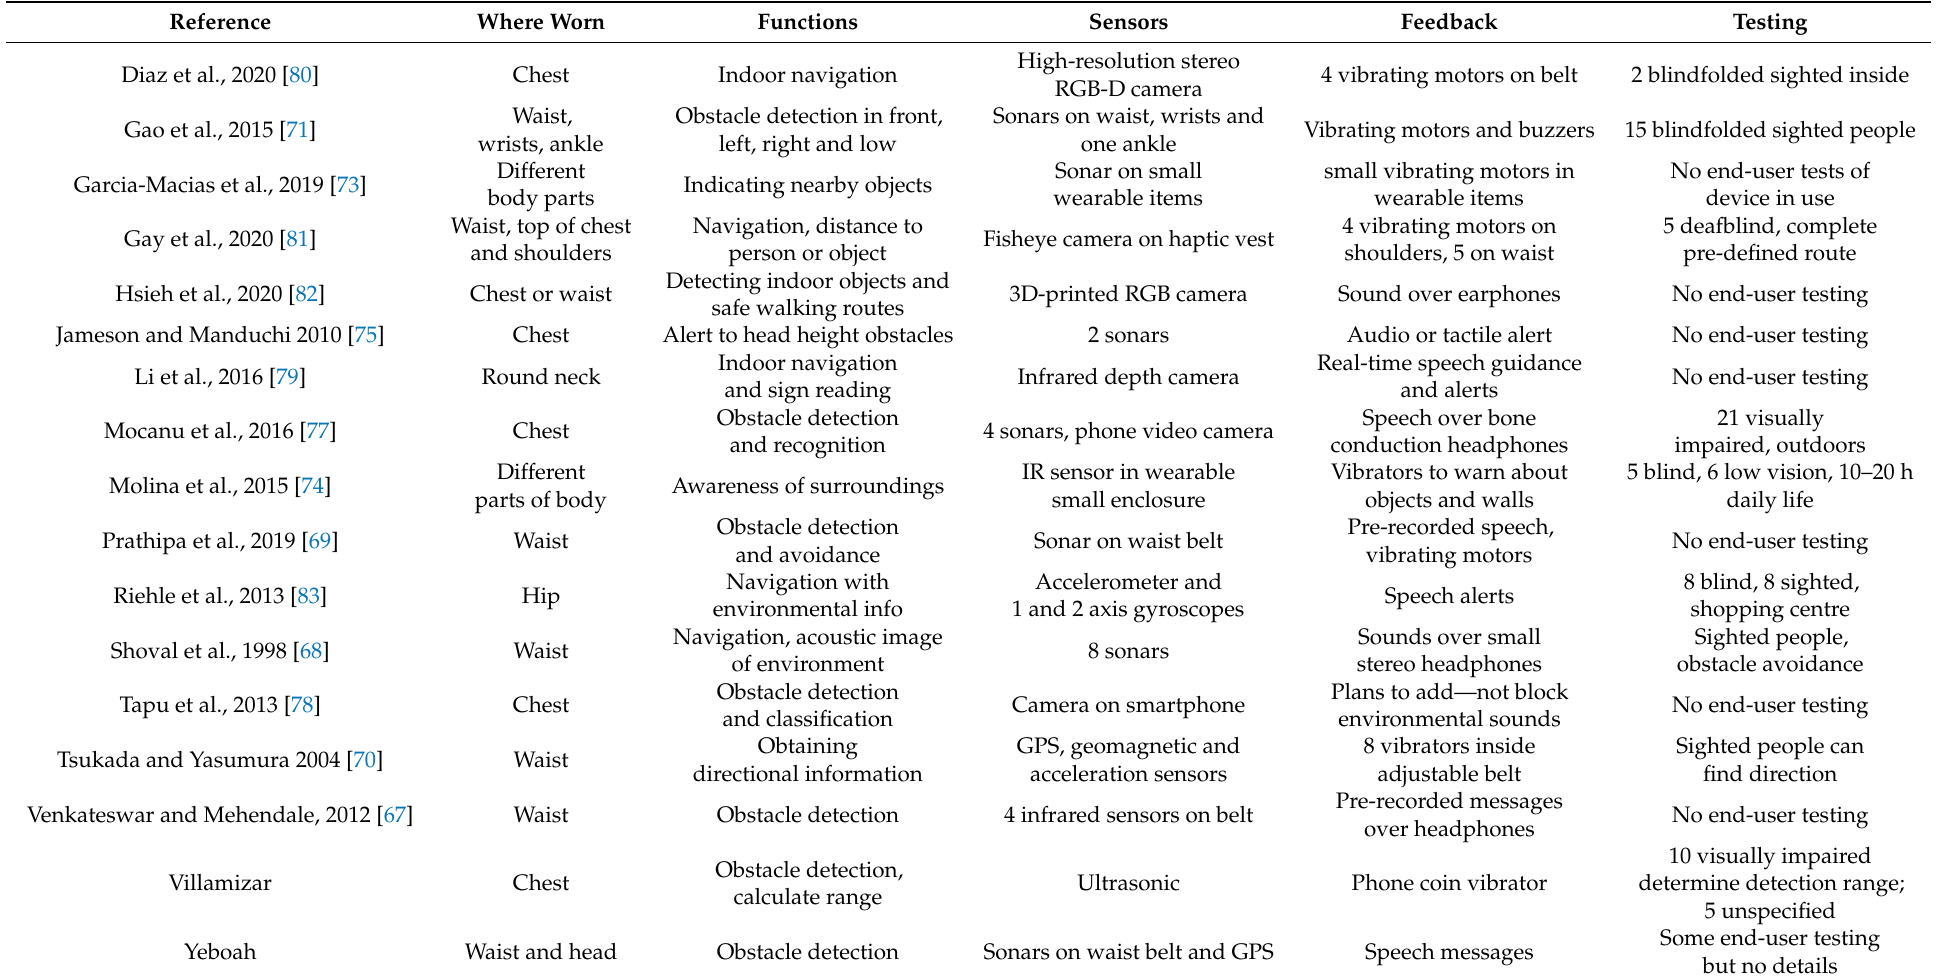
Table 3. Device features and testing for body-worn